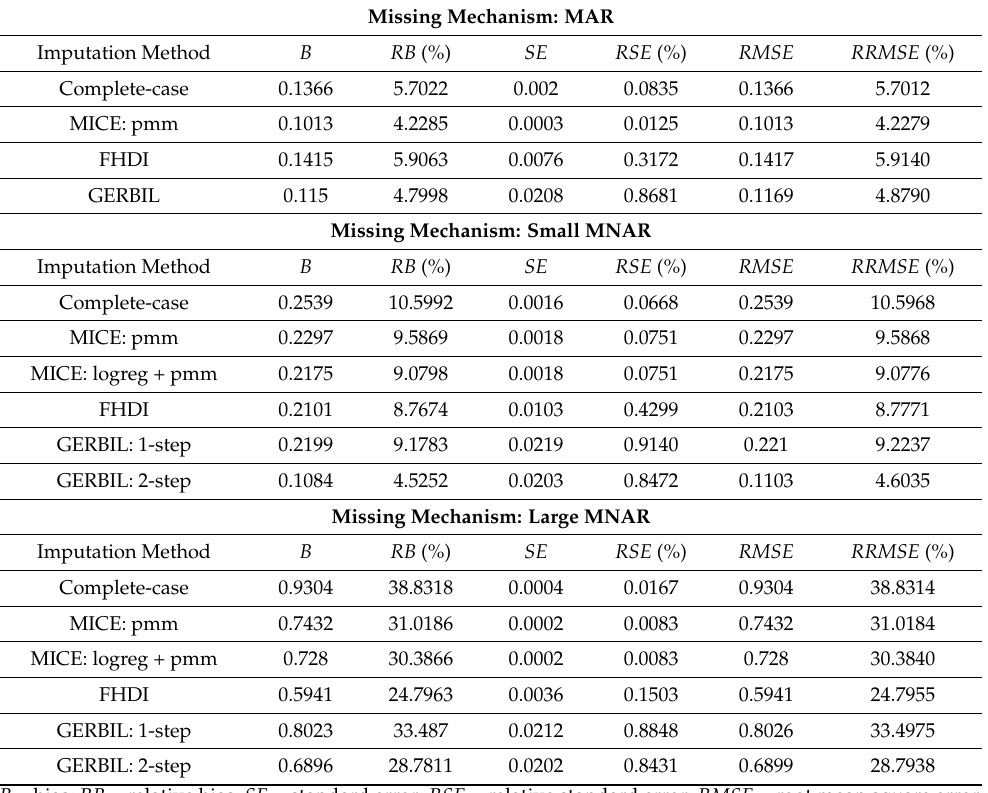
Table 2. Summary of Simulation Results for Mean of BRFSS Variable “Number of Feet Checks by Health Professional in the Past 12 Months”.